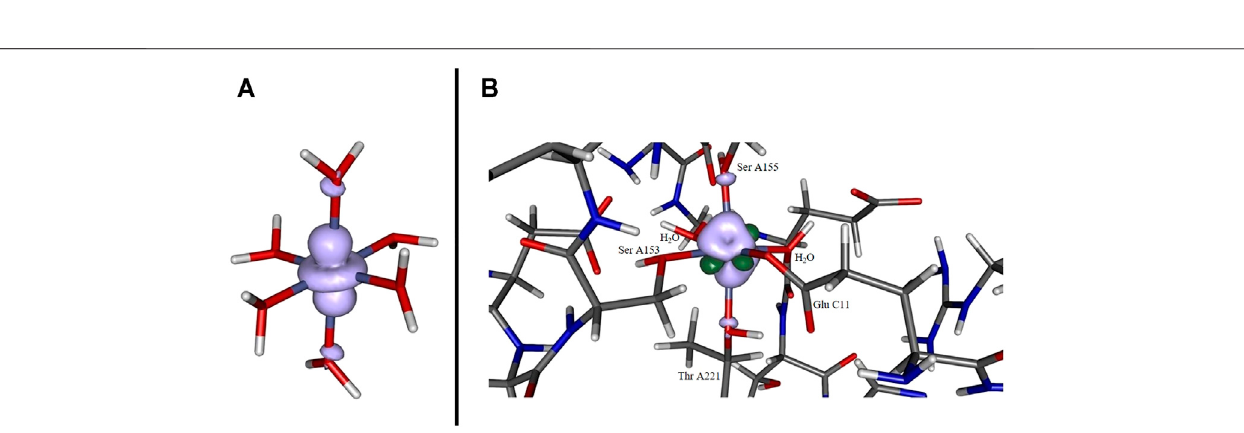
FIGURE 3 | Spin density for [Co(OH 2 ) 6 ] 2+ (panel A) and for the cobaltous model system (panel B) computed at the B3LYP/6-31G* level of theory. In the former case,